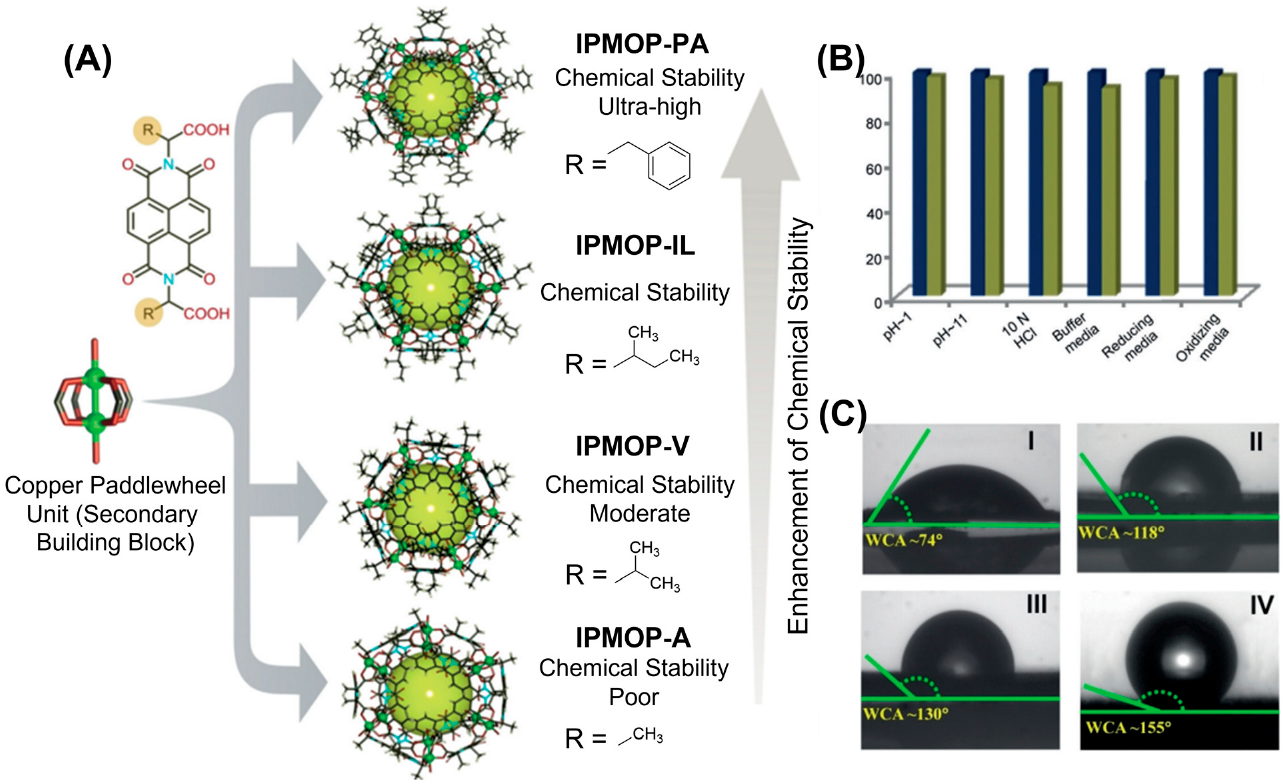
Figure 7. ( A ) Synthetic strategy for IPMOPs and their corresponding crystal structures following the systematic enhancement of their chemical stability (from bottom to top). ( B ) Bar diagram representing the reproducibility of the treatment of IPMOP-PA under various harsh conditions. Navy blue: before treatment of crystal, dark yellow: after crystal treatment. ( C ) Water droplet placed on pelletized IPMOPs, showing water contact angles (WCAs) of (I) ≈ 74 ◦ , (II) ≈ 118 ◦ , (III) ≈ 130 ◦ and (IV) ≈ 155 ◦ for IPMOP-A, IPMOP-V, IPMOP-IL and IPMOP-PA, respectively. Reprinted by permission from Ref. [75]. Copyright 2019 from